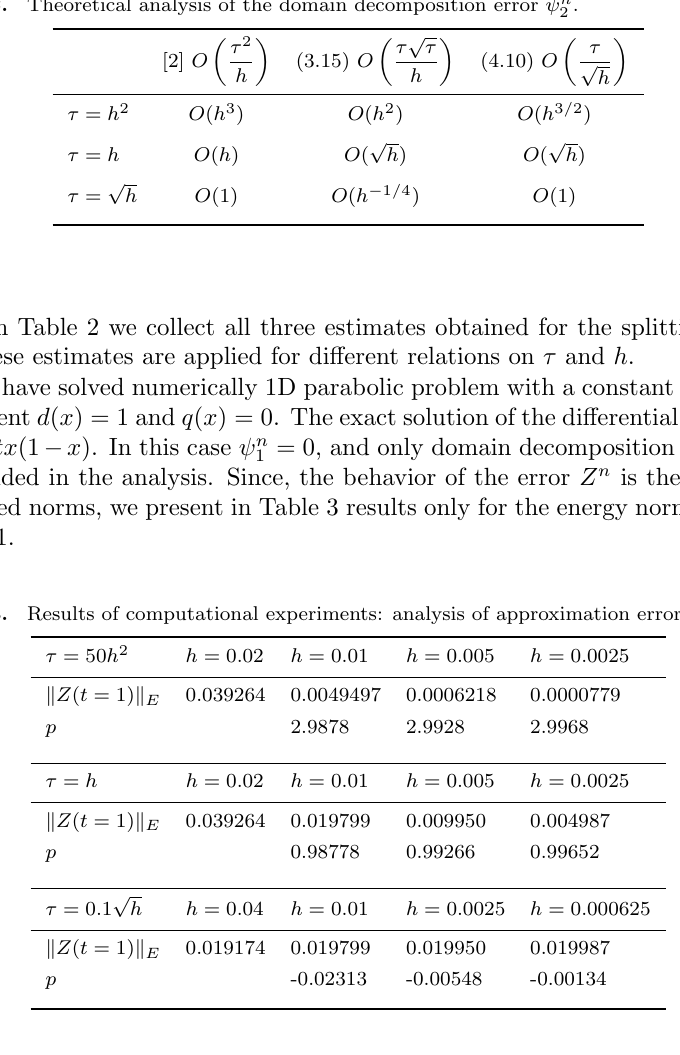
Table 2. Theoretical analysis of the domain decomposition error ψ n